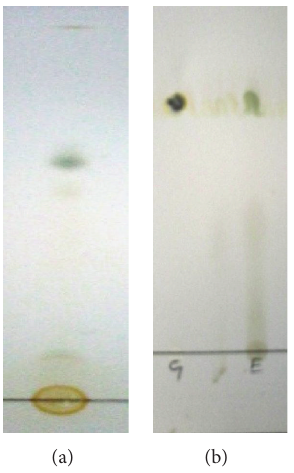
Figure 1: Identification of P-coumaric acid on TLC plate: (a) chro- matogram showing identification of P-coumaric acid standard; (b) separation of P-coumaric acid in methanolic extract of durva grass.